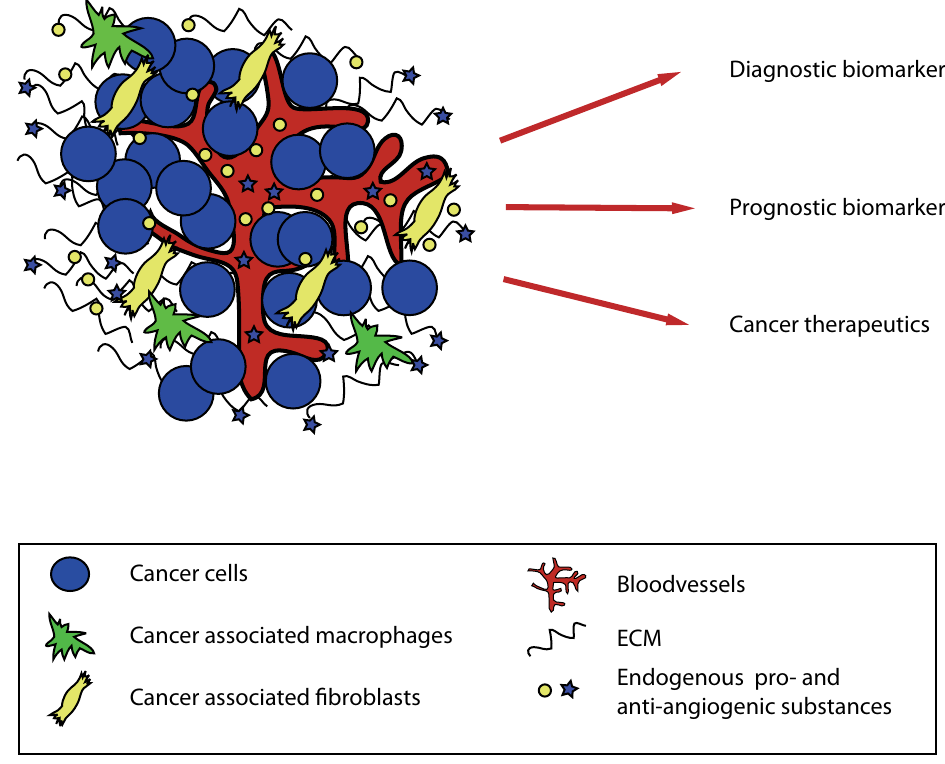
Figure 2. The potential use of matrix-derived anti-angiogenic molecules in human cancer. Substances cleaved from extracellular matrix proteins during tumor progression can be used as tumor markers and might also function as diagnostic and prognostic factors. These substances can also be given as